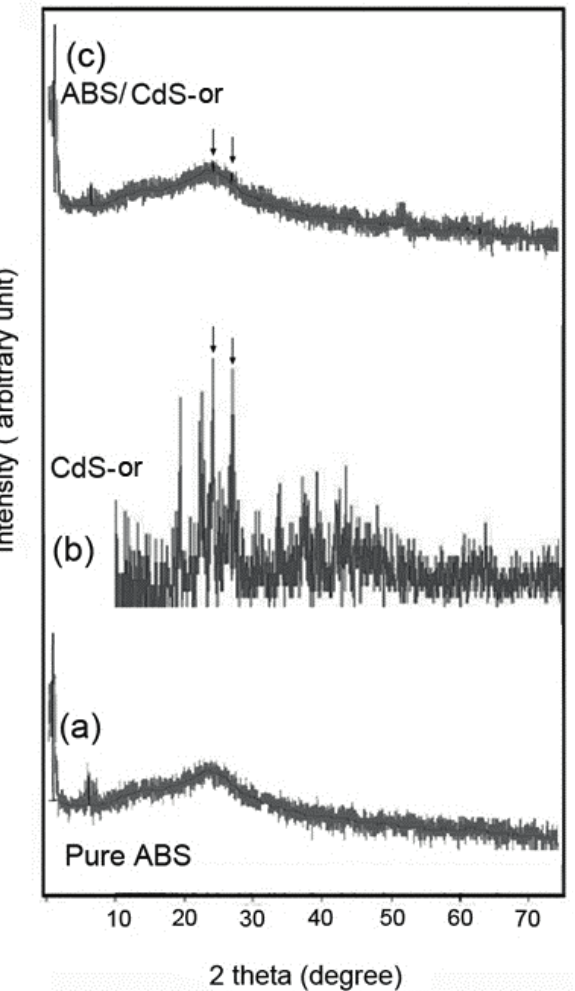
Figure 1. XRD patterns of (a) pure ABS, (b) flower like CdS-or and (c) ABS/CdS-or